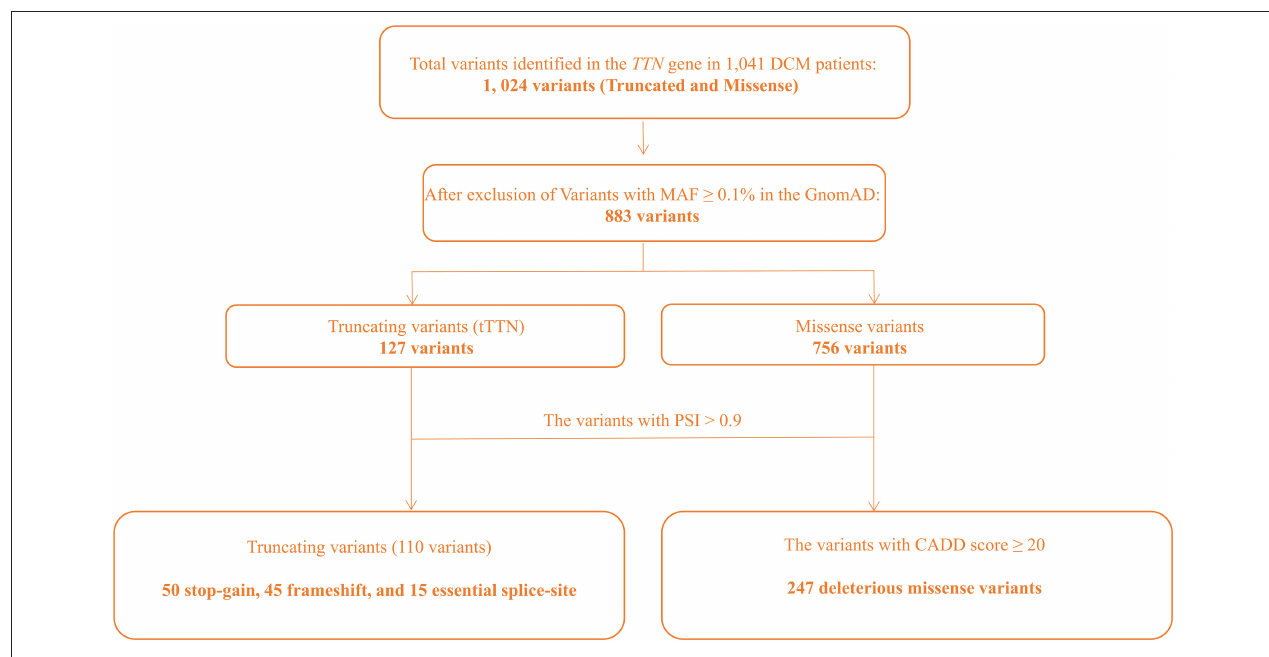
FIGURE 1 | Flowchart depicting approach to identification of the pathogenic variants in the TTN gene.